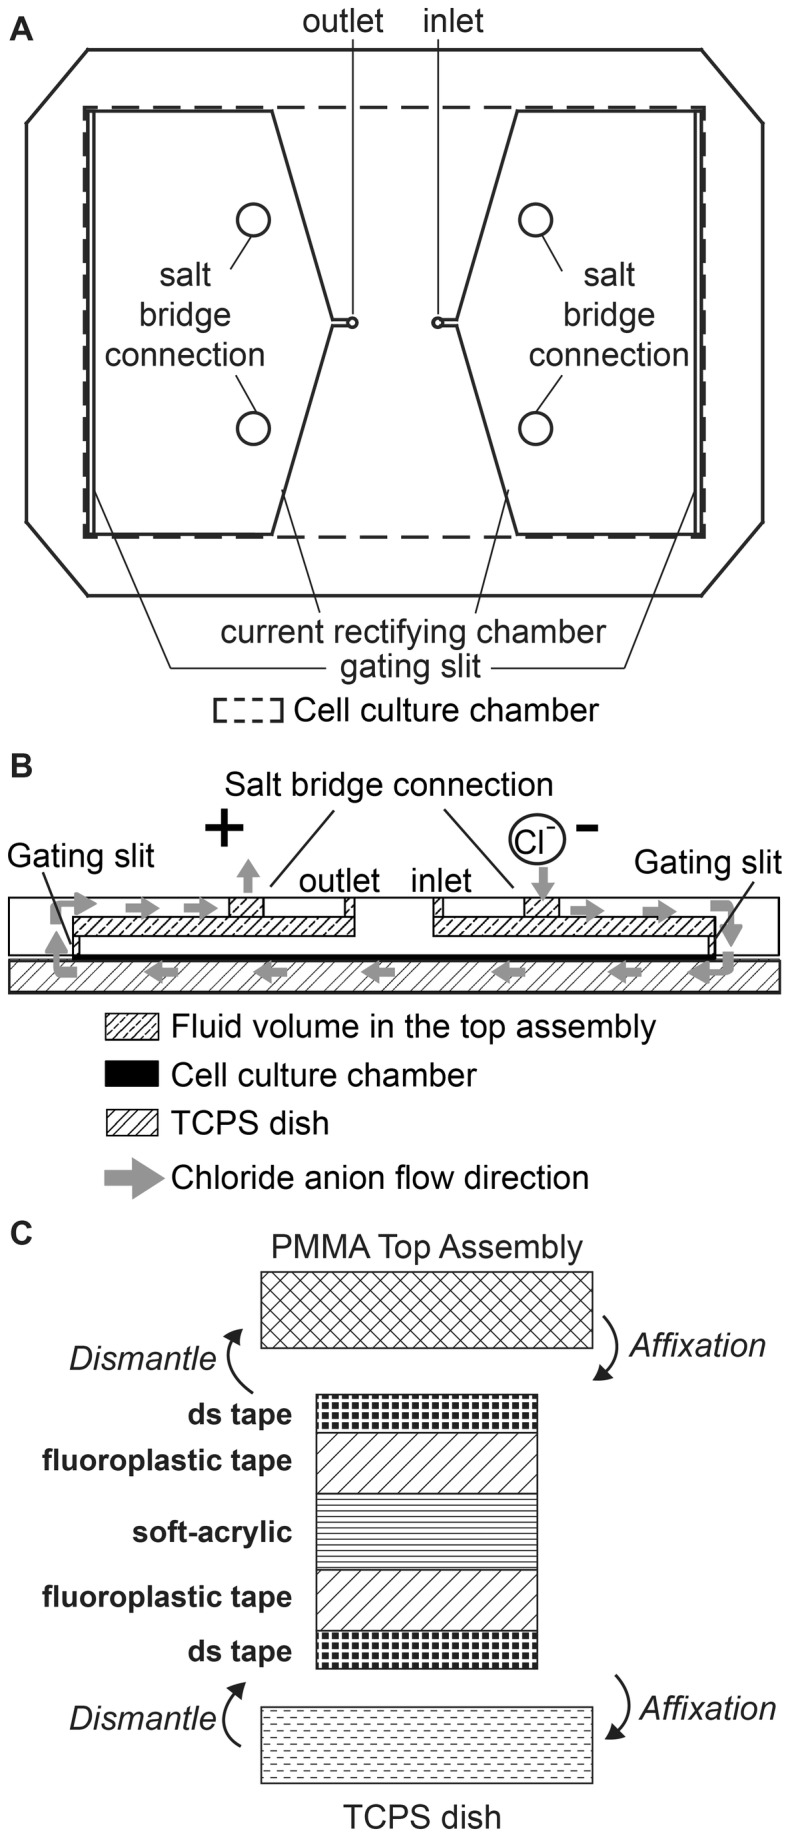
Detailed configuration of XLEFC.(A) The top view of the XLEFC top assembly design. The electrical current enters from the salt bridge connections through the current rectifying chamber and the gating slit, and then into the culture chamber. (B) The side view of XLEFC showing the integration of the top assembly, the cell culture chamber, and the TCPS dish. The flow direction of chloride ions, which are driven by the external dcEF, is shown in grey arrows. (C) The frame of the cell culture chamber has five layers, including one layer of soft-acrylic backbone, two layers of fluoroplastic tape, and two layers of double-sided tape (dstape). The design enables airtight seal during the experiment and quick release after the experiment.